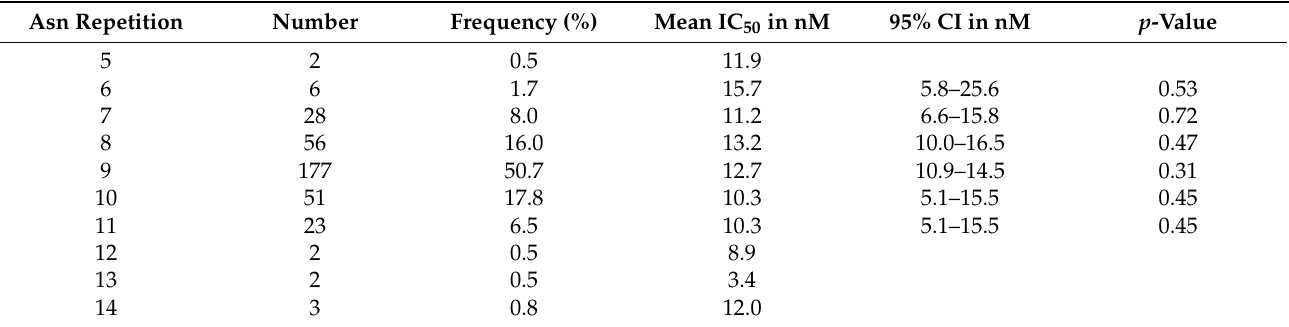
Table 4. Association between the Pfmdr5 686_694 Asn repeats among 349 clinical P. falciparum African isolates and ex vivo susceptibility to methylene